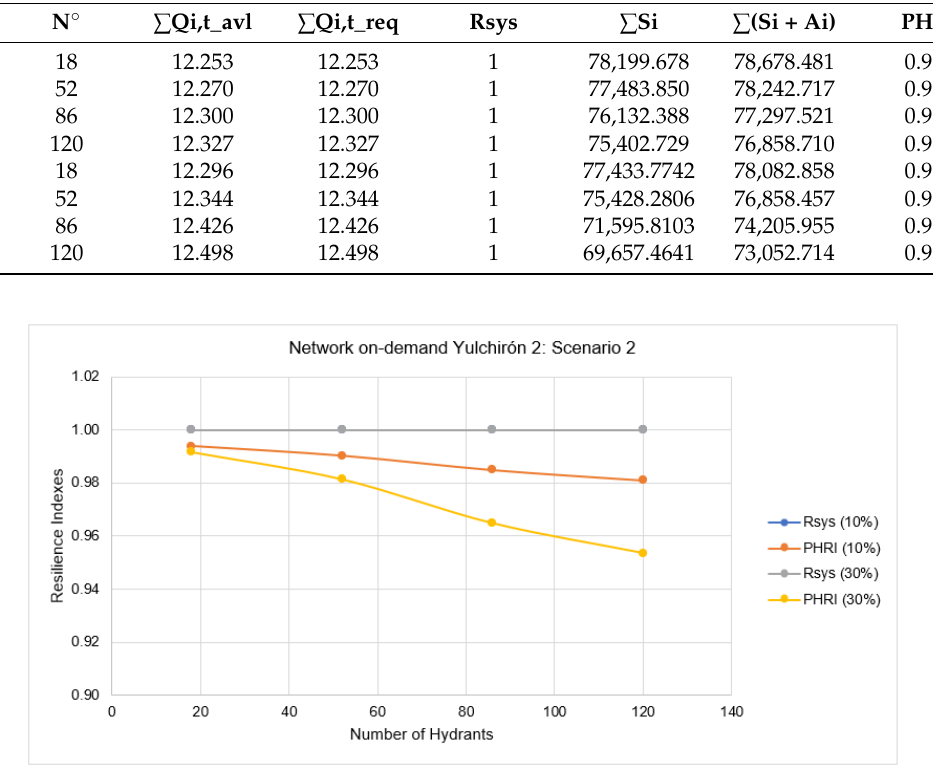
Figure 14. “Rsys” and “PHRI” results, in scenario 2 on-demand.